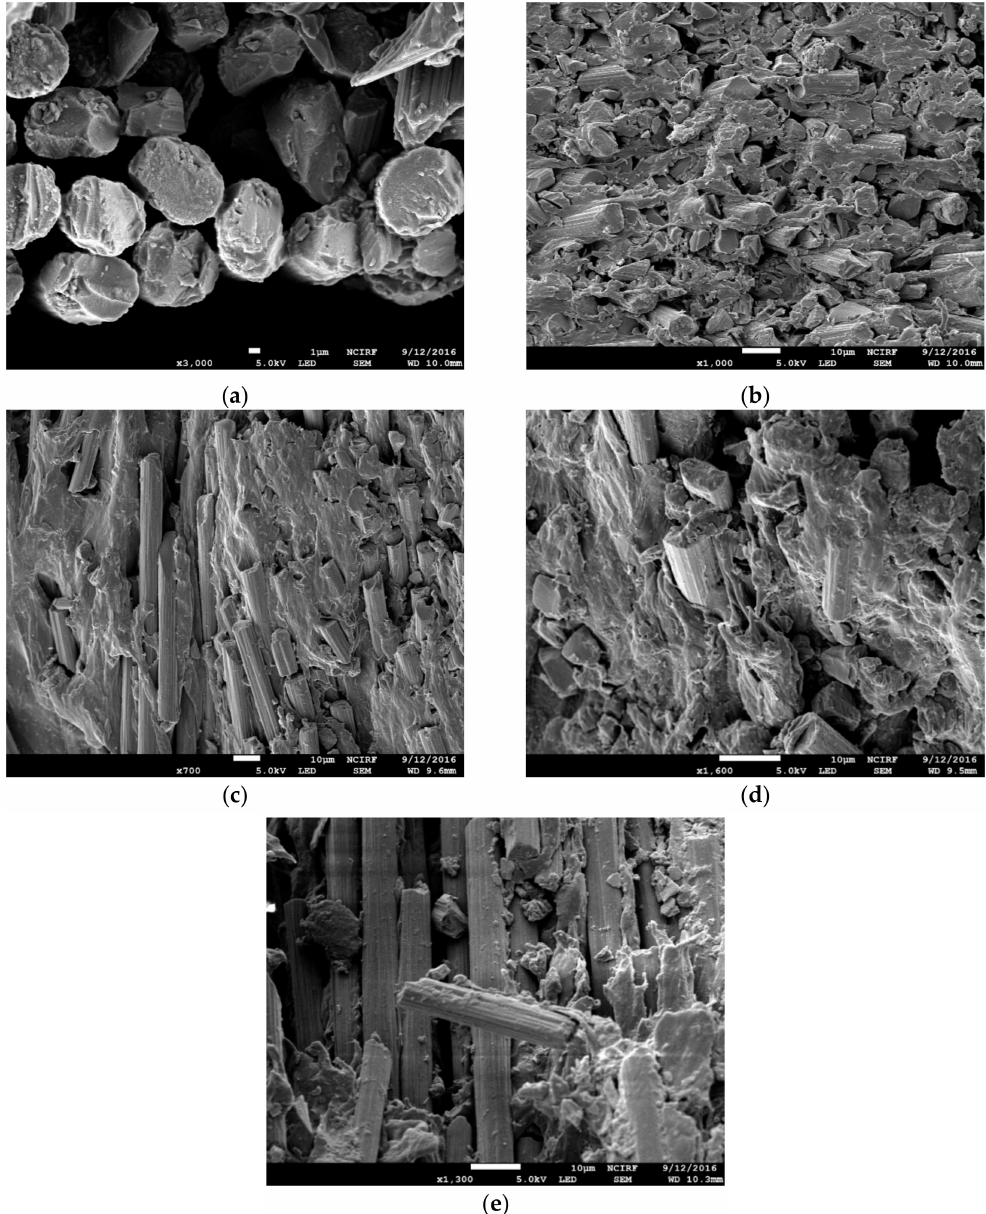
Figure 7. SEM micrograph of the fracture surface of the CFRTP composite at di ff erent molding temperatures: ( a ) 120 ◦ C, ( b ) 140 ◦ C, ( c ) 160 ◦ C, ( d ) 180 ◦ C, and ( e ) 200 ◦